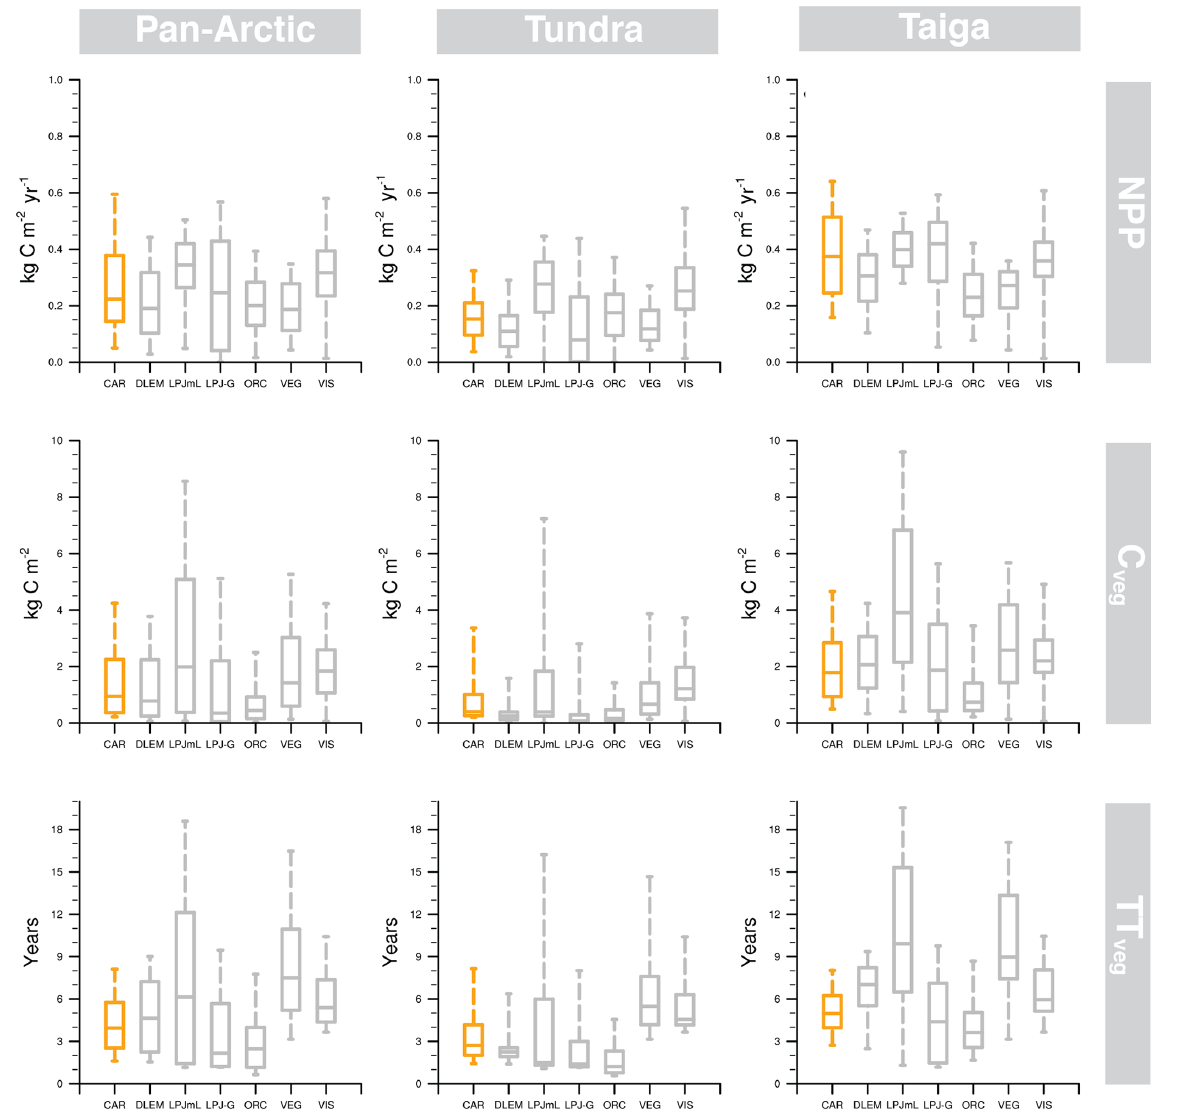
Figure 5. Central tendency and variability of NPP (net primary production), C veg (vegetation C stock), TT veg (vegetation transit time) estimated by CARDAMOM (orange), and ISI-MIP2a models (grey) in the pan-Arctic, tundra, and taiga regions. The box–whisker plots comprise the estimations between the 5th and 95th percentiles, and the box encompasses the 25th to 75th percentiles. The line in each box marks the median of studied variables in each